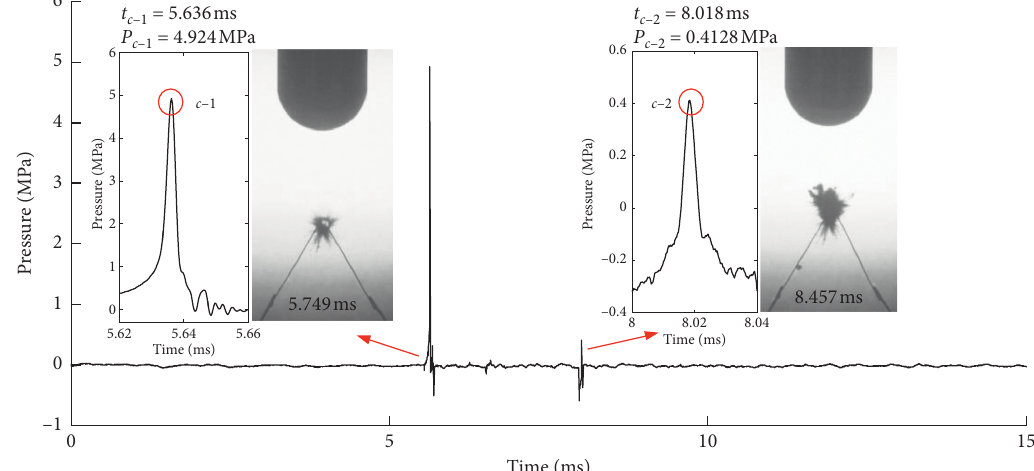
Figure 23: Pressure-time diagram of the first and second cycles of the spark-generated bubble load for c �